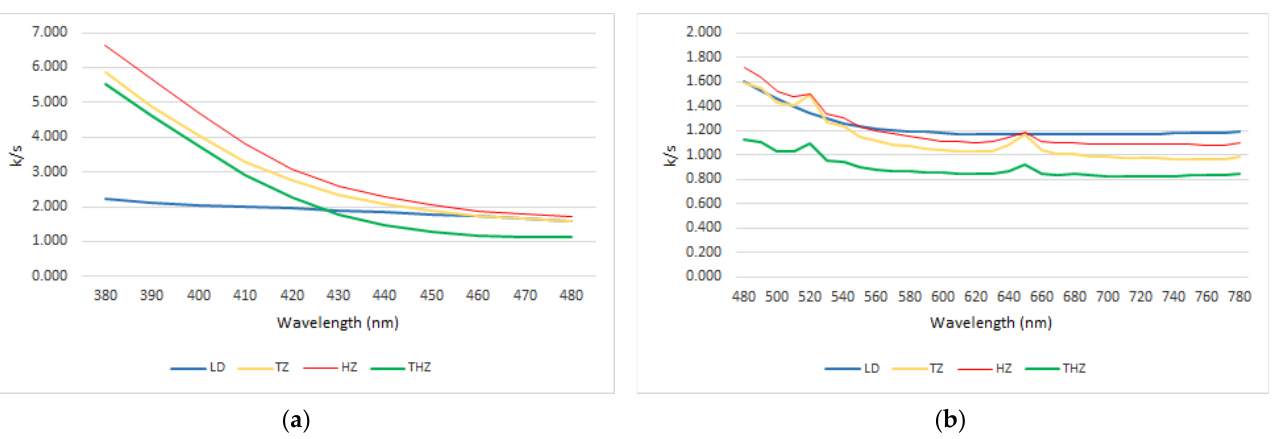
Figure 3. Spectral distribution of the K/S ratio for three zirconia and lithium disilicate. ( a ) Wavelength range from 380 to 470 nm. ( b ) Wavelength range from 480 to 780 nm.